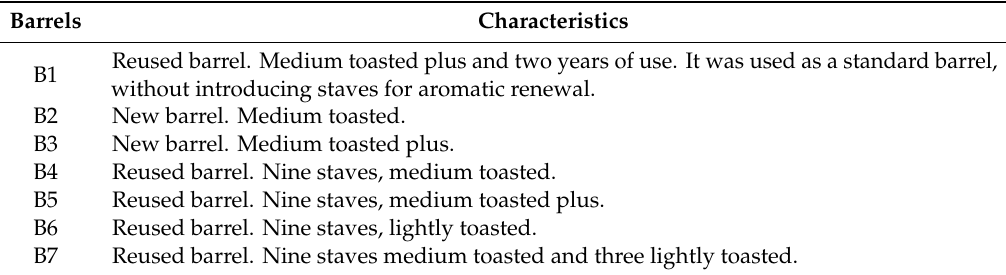
Table 4. Types of barrels used in the research.